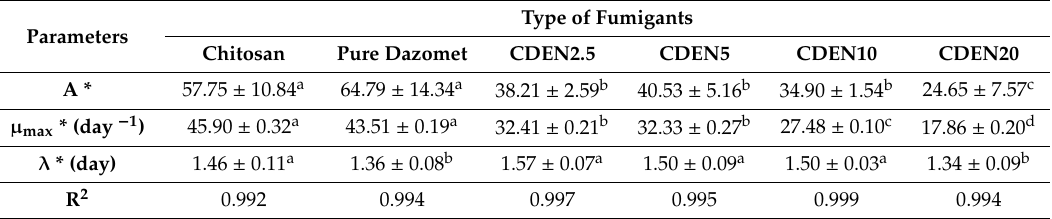
Figure 11. Growth curves fitted by the modified Gompertz model of G. boninense incubated at 10 ppb of ( A ) chitosan, ( B ) pure dazomet, and chitosan-dazomet nanoparticles at various concentrations of TPP: ( C ) 2.5, ( D ) 5, ( E ) 10, and ( F ) 20 mg / L (error bars represent standard deviation of the mean). Table 3. Fitted growth parameters according to the modified Gompertz